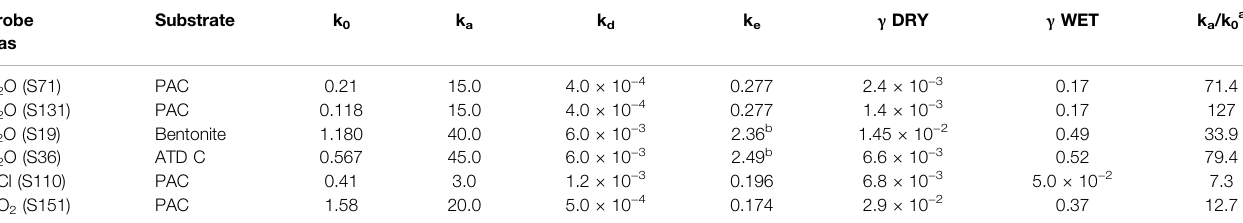
TABLE 3 | Desorption rate constants k d observed for small polar molecules for 1 mm Ø exit ori fi ce KFR. Probe Gas